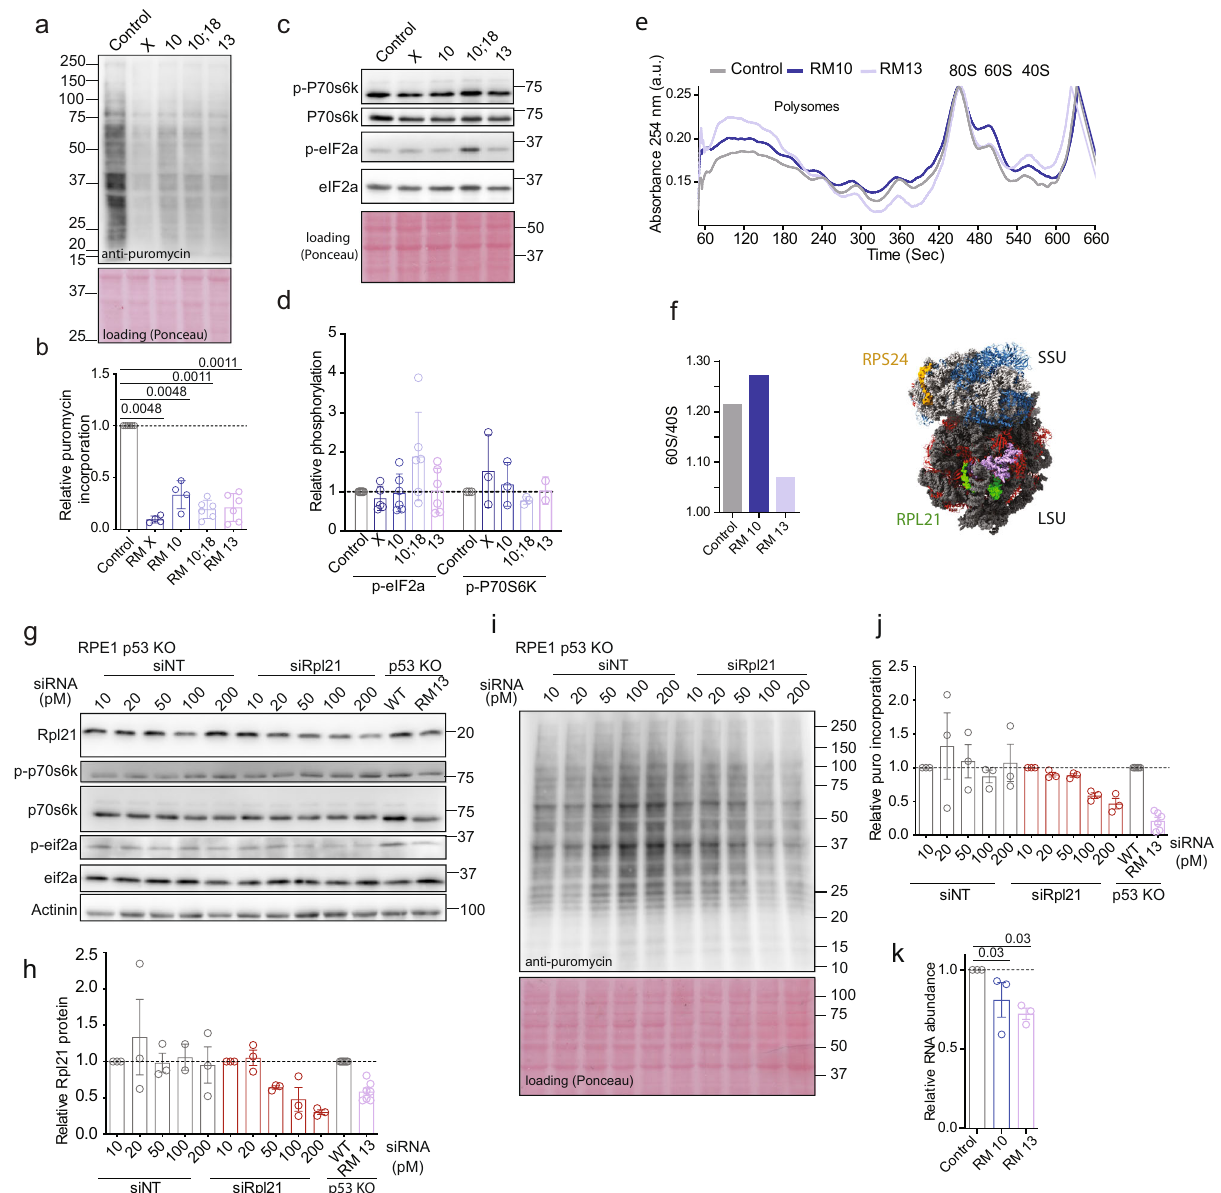
Fig. 5 Ribosome and translation defects in monosomies. a Evaluation of protein synthesis rates in monosomies. Equal amounts of puromycin-labeled cell lysates were immunoblotted and analyzed using anti-puromycin antibody. Ponceau staining was used as a loading control. b Quanti fi cation of mean puromycin intensities from immunoblotting. The intensities were normalized to Ponceau staining. Bars display the mean±SEM of four independent experiments for RM X and RM 10, and six independent experiments for other cell lines. Statistical analysis was performed by comparing to the respective controls using non parametric Matt Whitney two tailed T -test; p -values are shown on the plot. c Immunoblotting of mTOR target p70S6k and phospho-p70S6K and the integrated stress response marker eIF2 α and phospho-eIF2 α . d Quanti fi cation of relative phosphorylation levels of P70S6K and eIF2 α normalized to total protein levels, respectively. Bar graphs display the mean±SEM of three independent experiments for P70S6K and six for eIF2 α . e Polysome pro fi les obtained from diploid and monosomic cell lines. Pro fi les are representative of two independent experiments. The pro fi les were adjusted to the 80S peak. f Quanti fi cation of 60S/40S ratio of the representative polysome pro fi les. Peak absorbance for 60S and 40S were used for the calculations. Ribosome model shows the location of RPS24 (yellow) and RPL21 (green) proteins within the small and large ribosome subunit, respectively. g siRNA mediated titrated knockdown of RPL21 in RPE1 WT p53 KO cell line. siNT was used as a control; RPE1 p53 KO WT and RM 13 are shown as a non-transfected control. The western blots are representative of three independent experiments. h Quanti fi cation of RPL21 knock down ef fi ciency. siNT and siRPL21 values were normalized to respective 10pm samples. Bars display the mean±SEM of three independent experiments. i The effect of siRNA mediated knockdown of RPL21 on protein synthesis. Equal amounts of protein lysates from siNT and siRPL21 samples were immunoblotted against anti-puromycin antibody. Ponceau staining was used as a loading control. The western blots are representative of three independent experiments. j Quanti fi cation of translation rate after RPL21 knockdown. siNT and siRPL21 values were normalized to respective 10pm samples. Bars display the mean±SEM of three independent experiments. k Measurement of total RNA as a surrogate for rRNA levels and ribosome content. Bar graphs display the mean±SEM of three independent experiments. Statistical analysis was performed by comparing to the respective controls using non parametric Matt Whitney two-tailed T -test; p -values are shown on the plot. Source data are provided in a Source Data fi